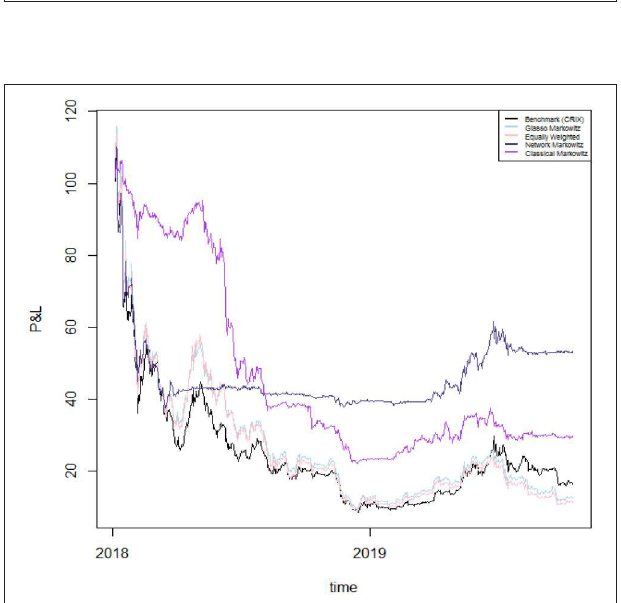
FIGURE 7 | Performances of selected portfolio strategies. The plot reports the profit and losses of a portfolio with initial value of 100 USD obtained by the CRIX benchmark index [Benchmark (CRIX)], the optimization using the Markowitz approach with the variance-covariance matrix filtered by Glasso (Glasso Markowitz), the naive portfolio (Equally Weighted), our optimization using RMT and MST applied to the variance-covariance matrix (Network Markowitz) and the standard Markowitz portfolio (Classical Markowitz). The portfolio values are plotted for the period 7 January 2018–17 October